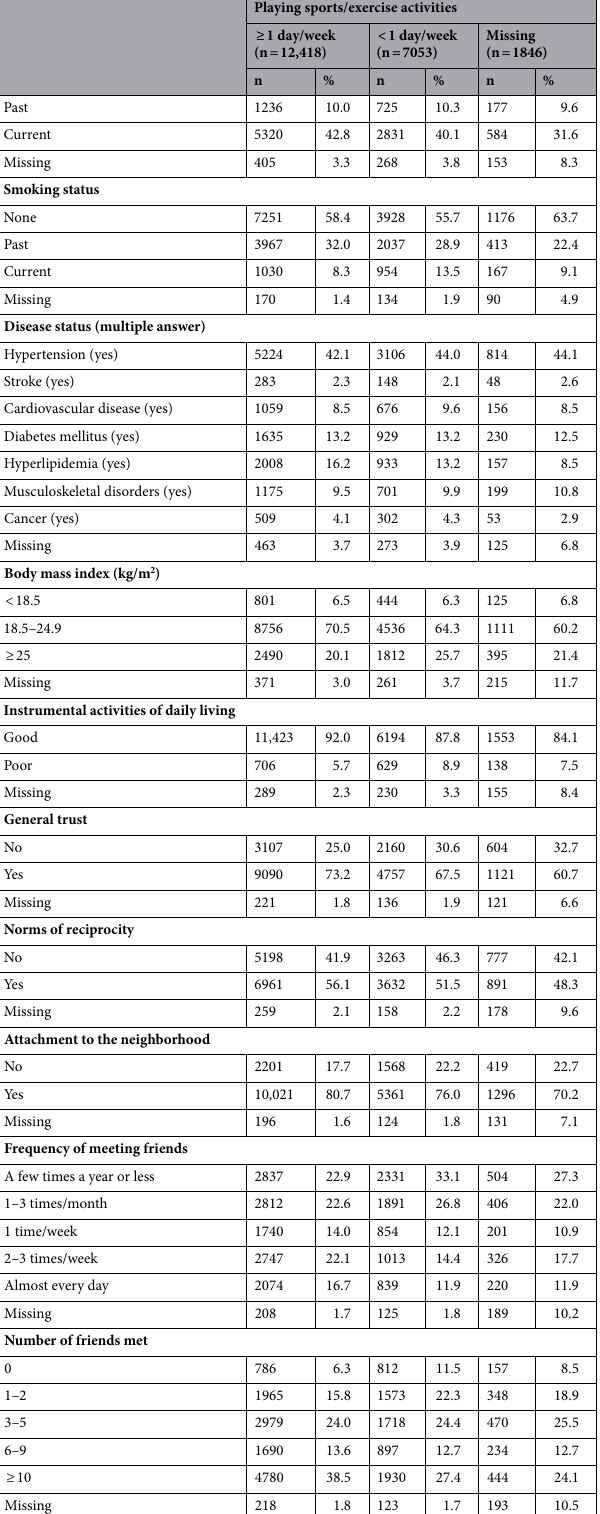
Table 1. Characteristics of the participants by each playing sports/exercise activities status (n = 21,317). Note: Data are from the Japan Gerontological Evaluation Study (JAGES), a nationwide mail survey that was conducted from December 2019 to January 2020. Missing values were imputed by using a multivariate normal imputation method in the main regression analysis. GDS: Geriatric Depression